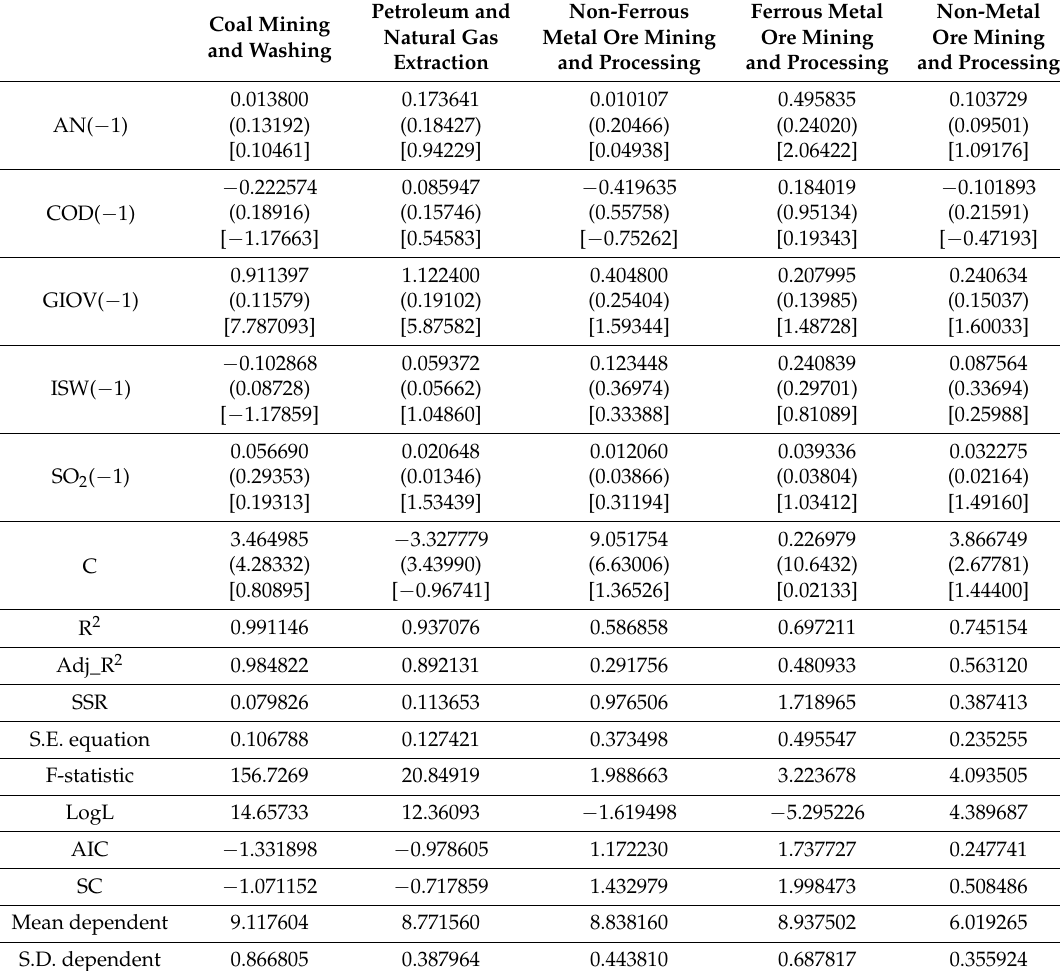
Table 17. Vector autoregression estimates.